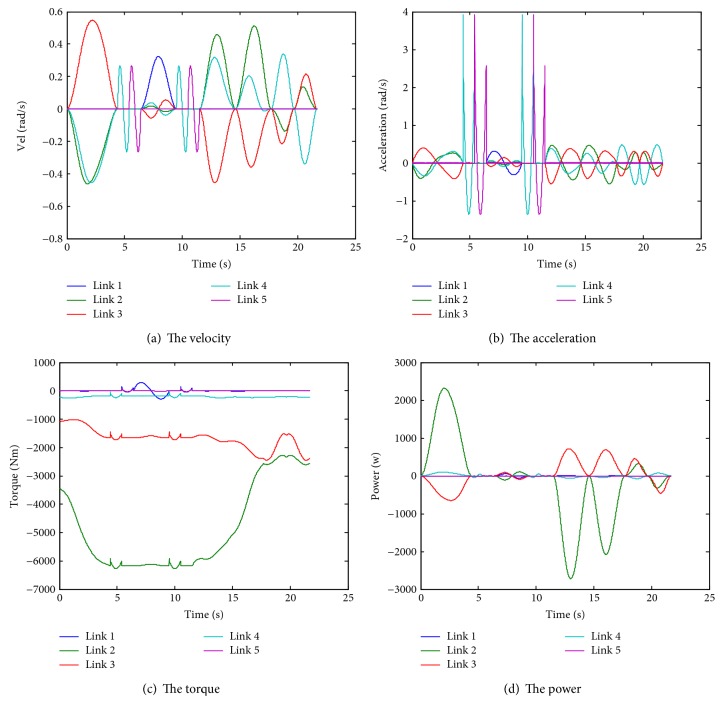
Simulation results.